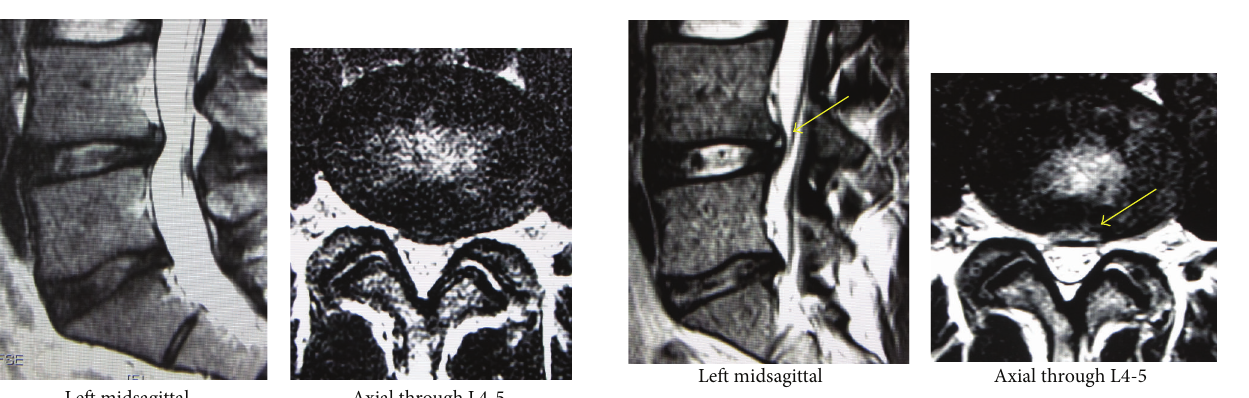
Figure 1: T2-weighted magnetic resonance imaging (MRI) findings on the initial visit. A degenerated disc with a slight protrusion is visible; however, no high signal intensity zone (HIZ) is obvious.